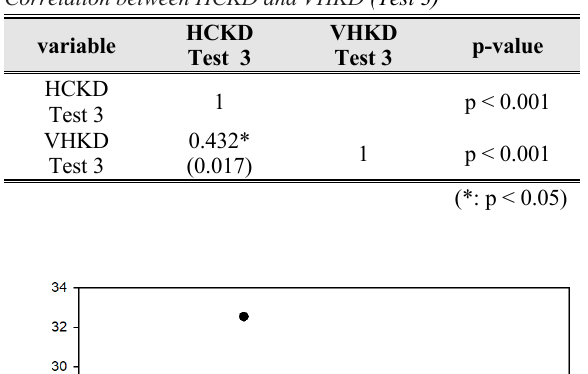
Correlation between HCKD and